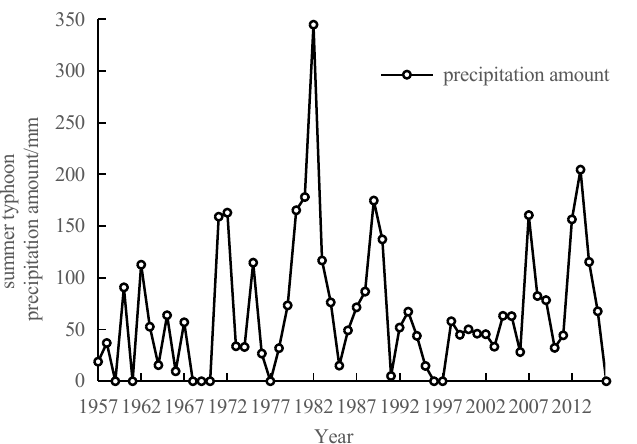
Figure 3. Summer typhoon precipitation amount during 1957–2016 in Anhui Province.